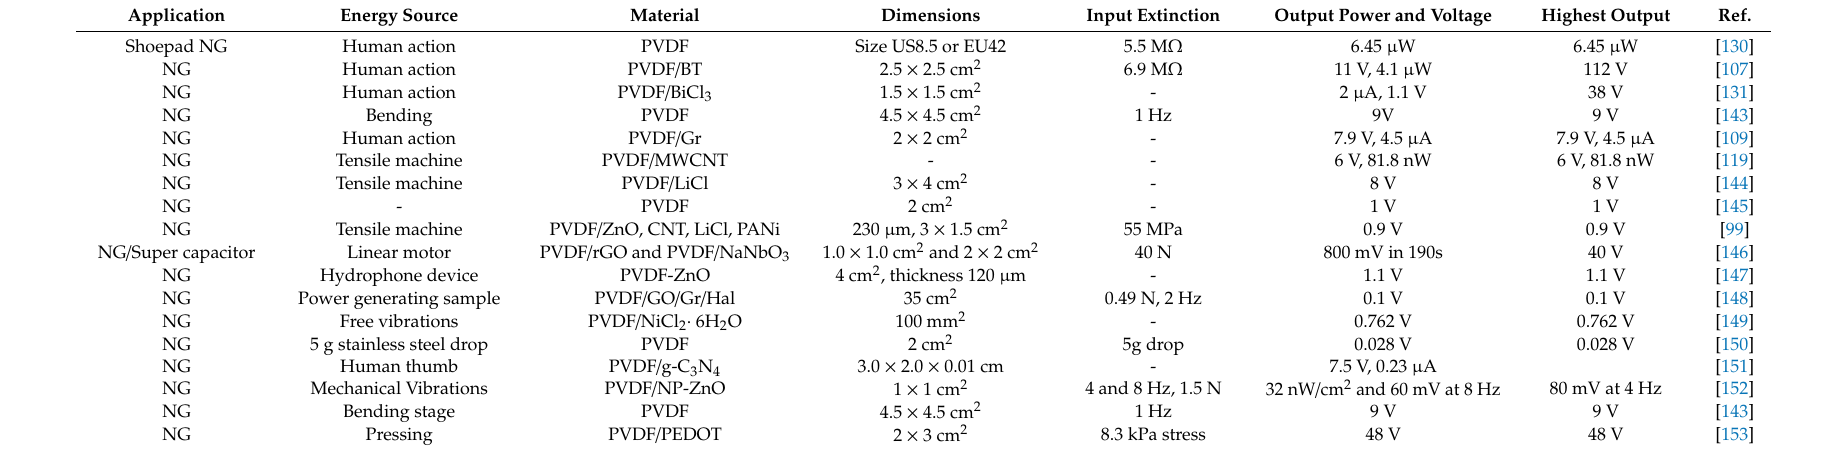
Table 6. Summary of applications of electrospun PVDF as